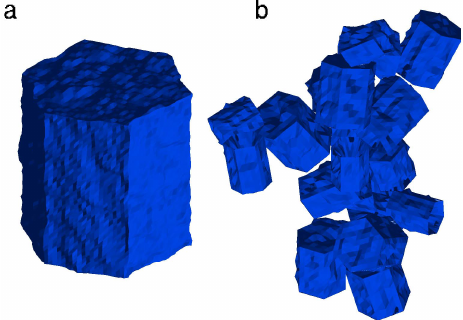
Figure 2. Particle geometries for the two-habit model (THM): (a) single hexagonal column with an aspect ratio of unity, and (b) hexagonal aggregate with 20 solid or hollow